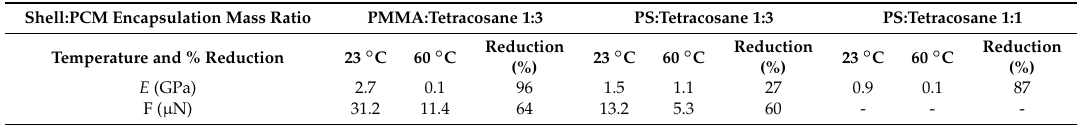
Table 1. Summary of results for the different temperatures, different shells, and different encapsulation mass ratio by means